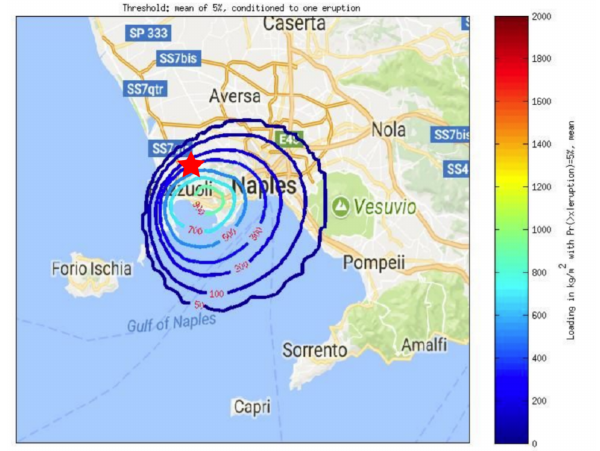
Figure 2. The location reference site for this study (red star) along with the hazard map relative to the probability of 5% of exceedance, conditional upon the occurrence of one eruption of whatever size and from whatever vent at Campi Flegrei (mean of the epistemic uncertainty). The figure has been obtained modifying the Fig. 11 of the corrigendum to the paper Selva et al. (2018) (available at https: //doi.org/10.1016/j.jvolgeores.2018.07.008); the original maps have been obtained with the MATLAB software.